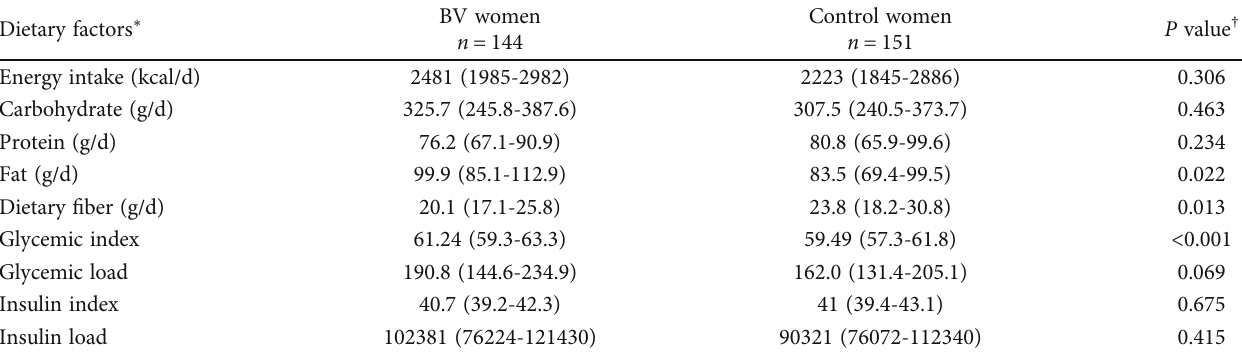
Table 2: Dietary intake and dietary carbohydrate indices among bacterial vaginosis cases and controls.